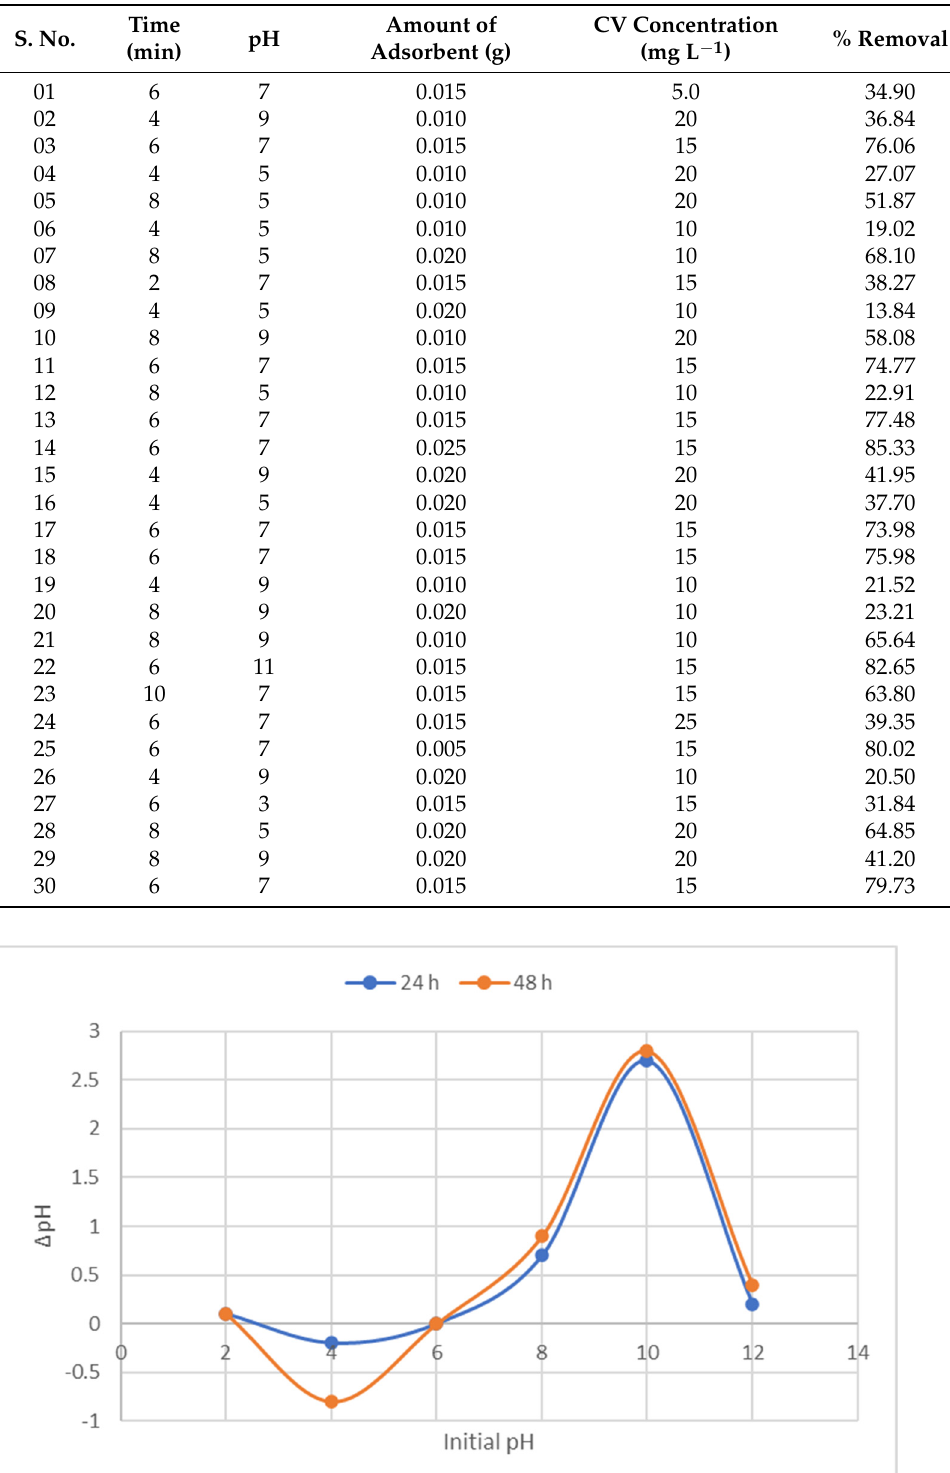
Table 1. Central composite design and the observed responses for the decontamination of CV from an aqueous medium. S. No.